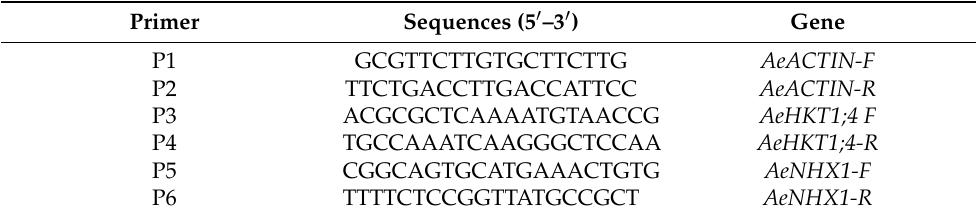
Table 6. Sequence of primers used for real-time PCR